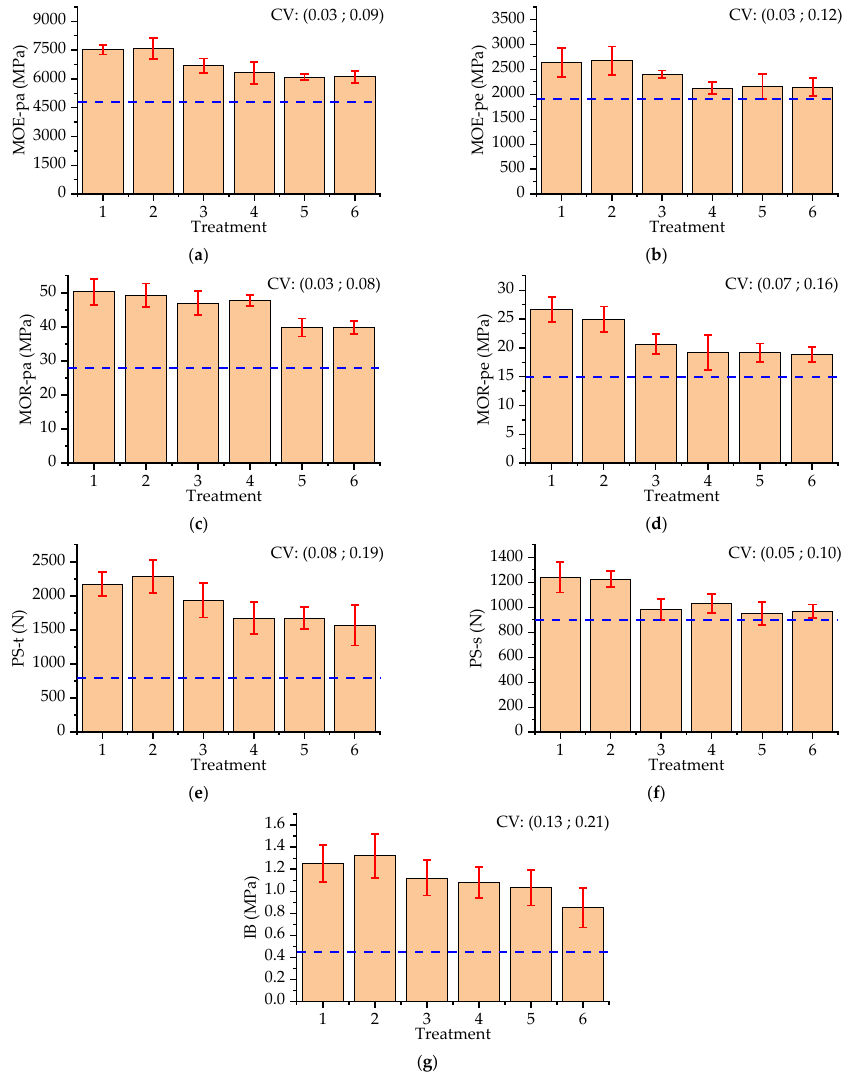
Figure 6. Mechanical properties results: ( a ) Parallel modulus of elasticity (MOE-pa), ( b ) Perpendicular modulus of elasticity (MOE-pe), ( c ) Static parallel bending (MOR-pa), ( d ) Static perpendicular bending (MOR-pe), ( e ) Resistance to withdrawal of screws—top (PS-t), ( f ) Resistance to withdrawal of screws—surface (PS-s), ( g ) Perpendicular traction or internal bonding (IB). Note: The dashed lines represent the values defined by the normative limits, whiskers red lines the Standard deviation, and CV the Coefficient of Variation.